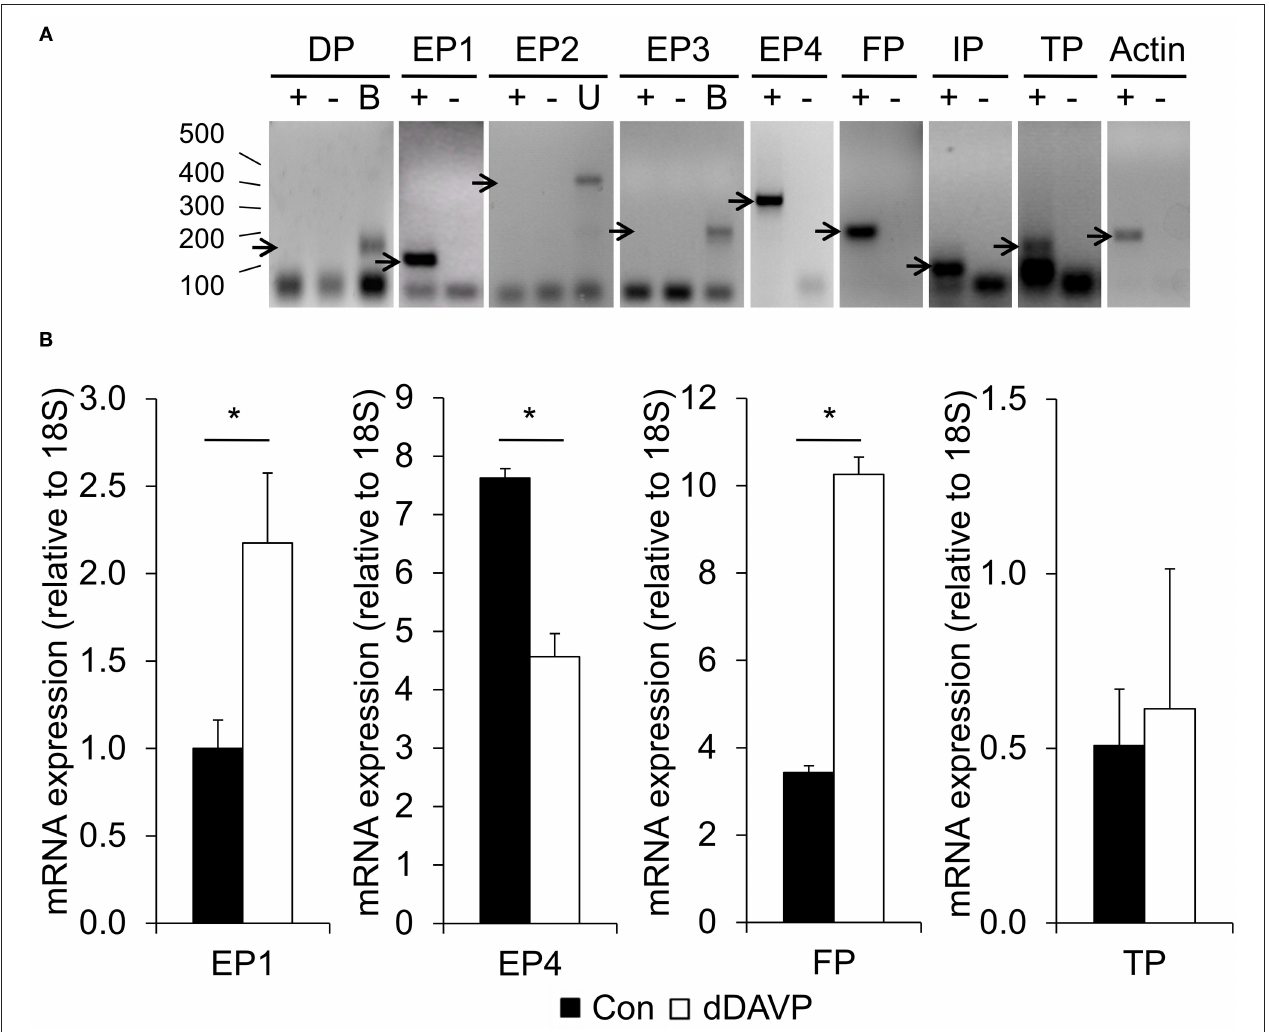
FIGURE 4 | Prostaglandin receptor expression. (A) MpkCCD c14 cells were grown for 8 days. Cells were lysed, total RNA was isolated, and RNA was reverse-transcribed into cDNA. By using the reverse-transcriptase polymerase chain reaction (RT-PCR), the expression of the prostaglandin receptors was analyzed. β -actin was used as a positive control for cDNA amplification. ± = with or without reverse transcriptase during the cDNA production. B, brain, U, uterus. Sizes in bp are indicated on the left. Arrows point at product of expected size. (B) MpkCCD c14 cells were grown for 8 days and incubated with or without (con) 1nM dDAVP for the last 4 days. Total RNA was isolated, RNA was reverse-transcribed into cDNA, and the relative expression of the prostaglandin receptors was analyzed by performing the quantitative (q)RT-PCR. The signals obtained from the house-keeping 18S were used to normalize for difference in the amount of starting cDNA. Bars are mean values of eight filters per condition ( ± SEM). Significant differences ( p < 0.05) from control are indicated by an